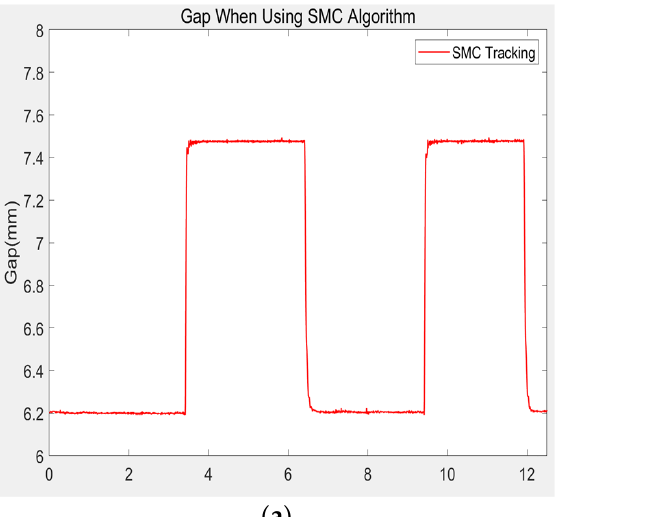
Figure 20. Gap and current value under PID control algorithm: ( a ) Gap value; ( b ) current value.